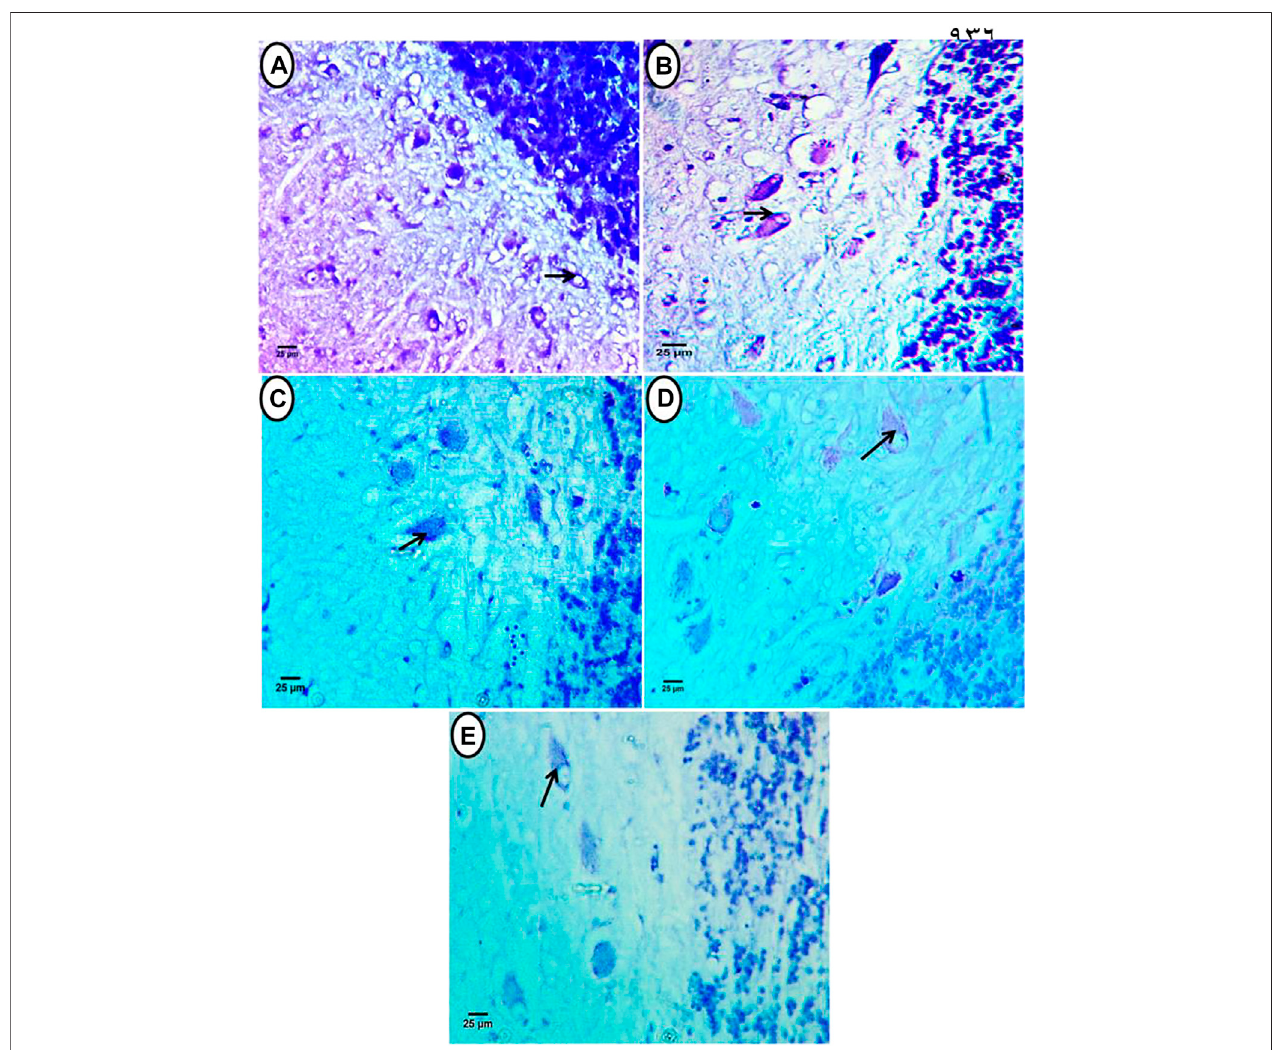
FIGURE 4 | Transverse sections of cerebellum of African cat fi sh ( C. gariepinus ) exposed to PE-MPs and PE-MPs with lycopene, citric acid, and chlorella as antioxidantsfor15 days. (A) ControlgroupshowedPurkinjecellswithnormaldistributionofNisslesubstabncesperinuclei. (B) (PE-MPs500 mg/kgdiet)exposedgroup showed shrunken Purkinje cells containing deeply stained Nissle granules. (C) PE-MPs + lycopene (500 mg/kg diet), (D) PE-MPs + citric acid (30 g/kg diet) and (E) PE- MPs + chlorella (50 g/kg diet) exposed groups, showed a slight decrease in RNA contents. Remarkable decrease was observed in PE-MPs + citric acid (30 g/kg diet) exposed group, Cresyl violet, Scale bar 25